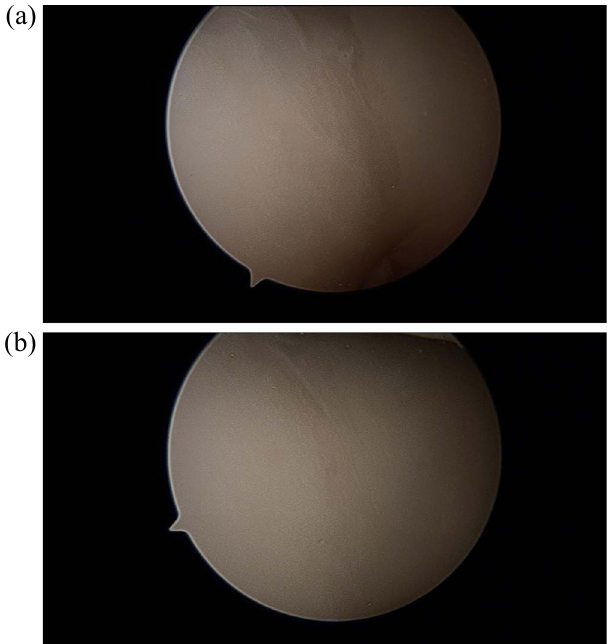
Figure 9. Second look arthroscopy showing excellent incorporation of the previously fi xed chondral fragment with minimal articular cartilage irregularities (a and b).